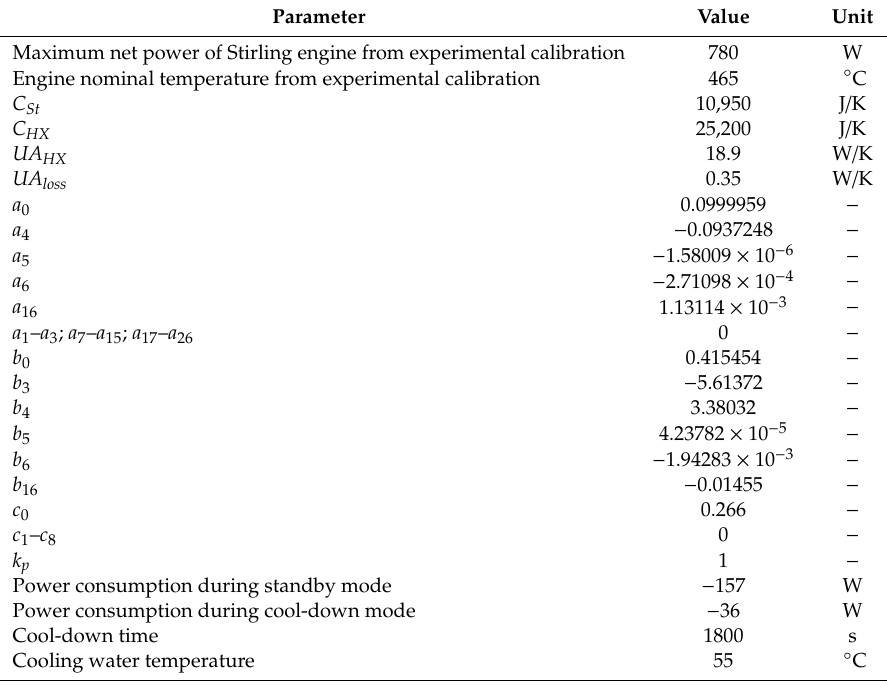
Table 7. Stirling engine